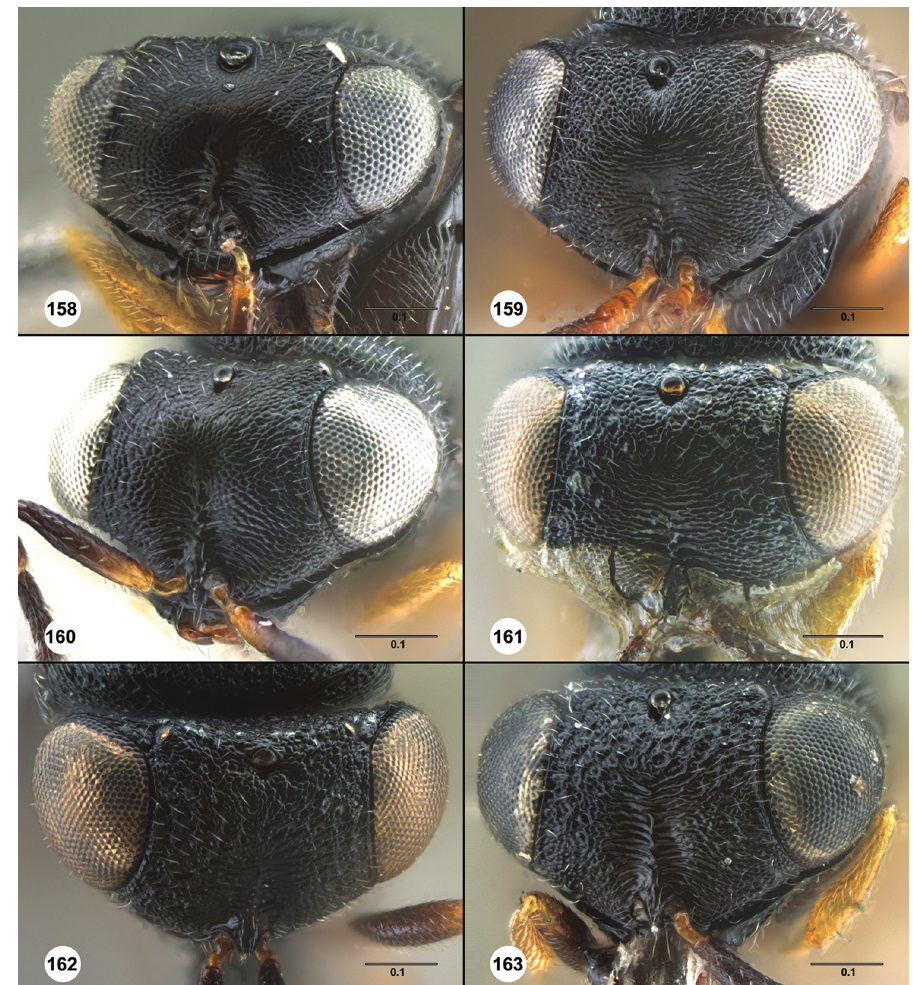
Figures 158–163. Trissolcus scutellaris 158 male, paralectotype of T. vassilliewi (USNMENT01029319), head, anterior view 159 female (USNMENT00896094), head, anterior view 160 female (USN- MENT00896103), head, anterolateral view 161 female paralectotype of T. simoni (USNMEN- T01059022a), head, anterior view 162 female lectotype of T. simoni (USNMENT01059022b),